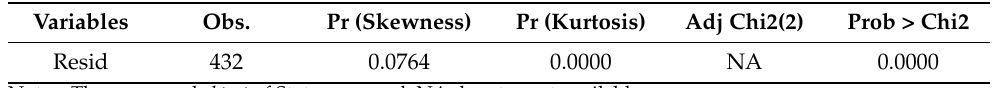
Table 5. Skewness/kurtosis tests for